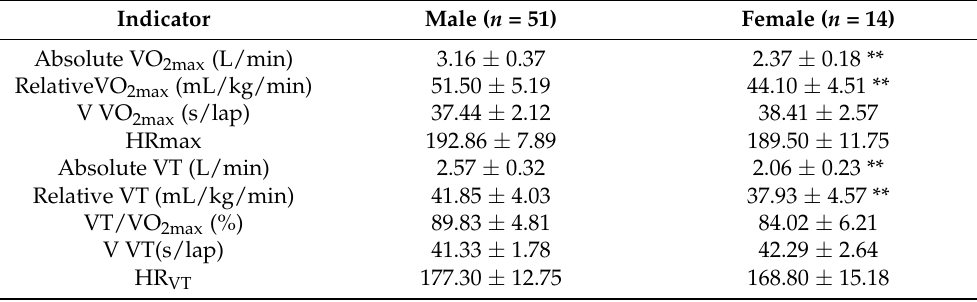
Table 5. On-Ice Aerobic Testing Result for All Participating Athletes ( n =